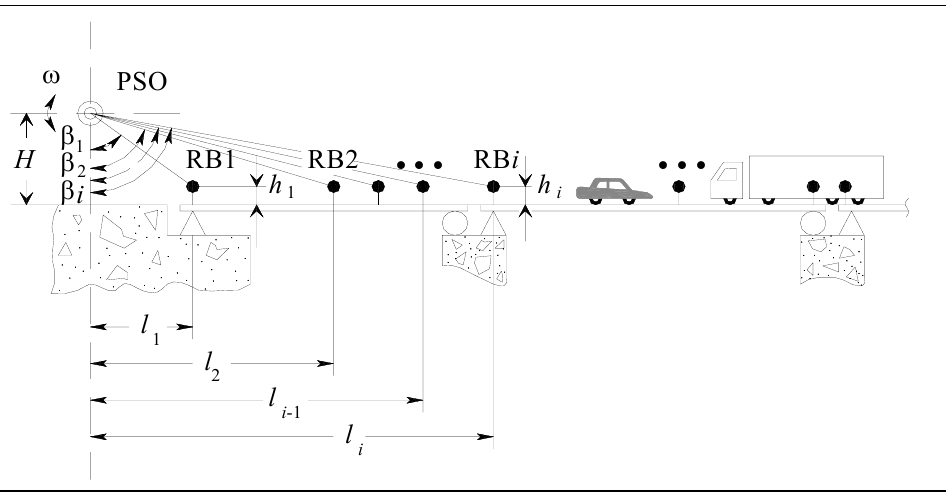
Figure 3. Horizontal POS placement for bridge